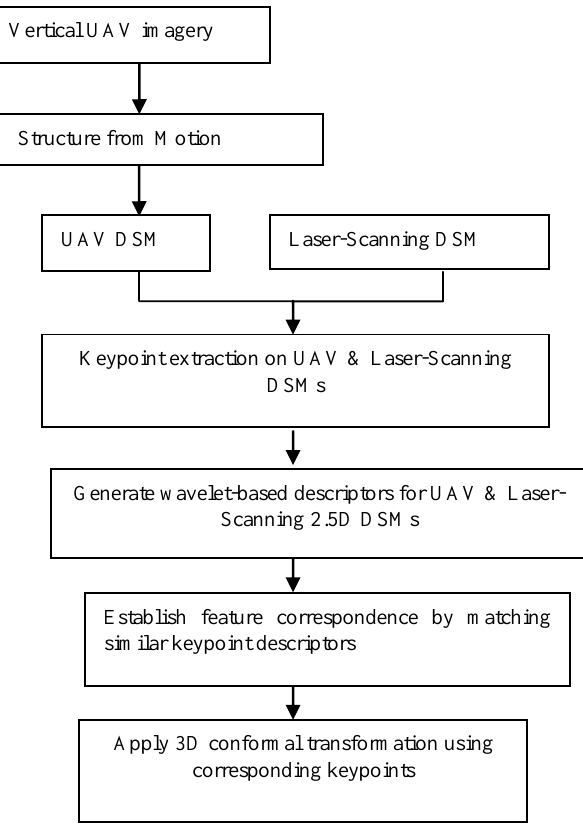
Figure 1. Proposed approach for UAV & TLS point cloud DSM